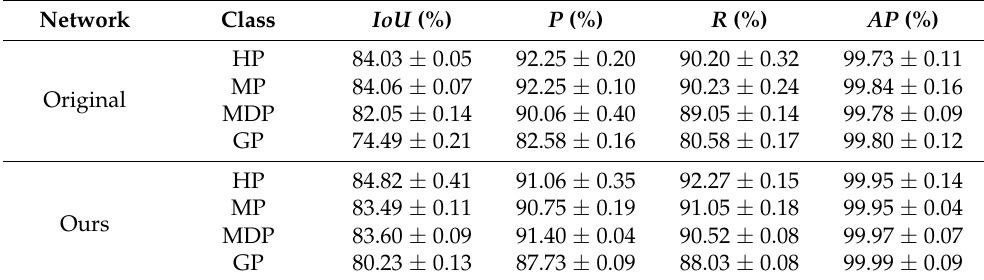
Table 1. Peanut defect identification results based on VGG16 and improved algorithm.